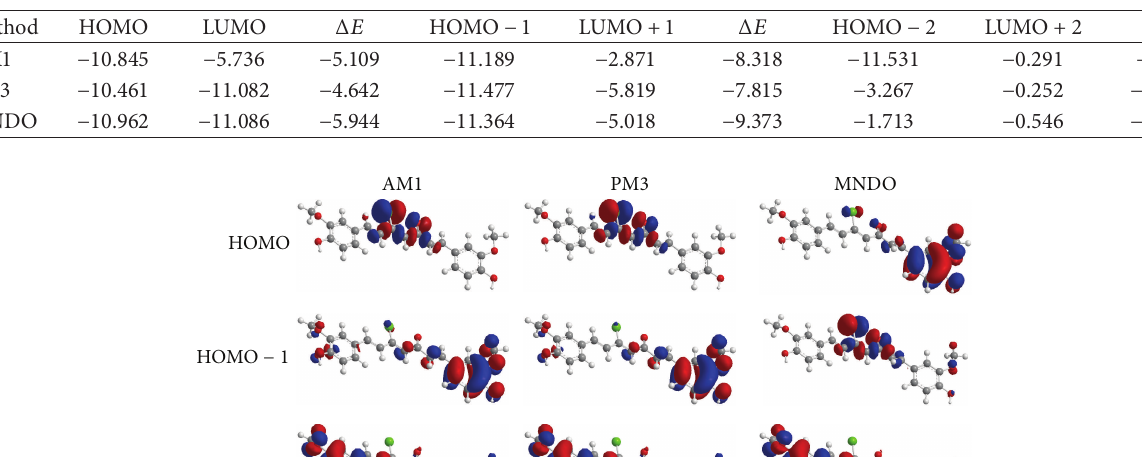
on carbon-carbon double bond (C10-C11) for AM1 and PM3 but delocalized on the benzene ring for MNDO. However, HOMO − 1 was delocalised on the benzene ring for AM1 and PM3 but delocalised on the carbonyl, chloride and also